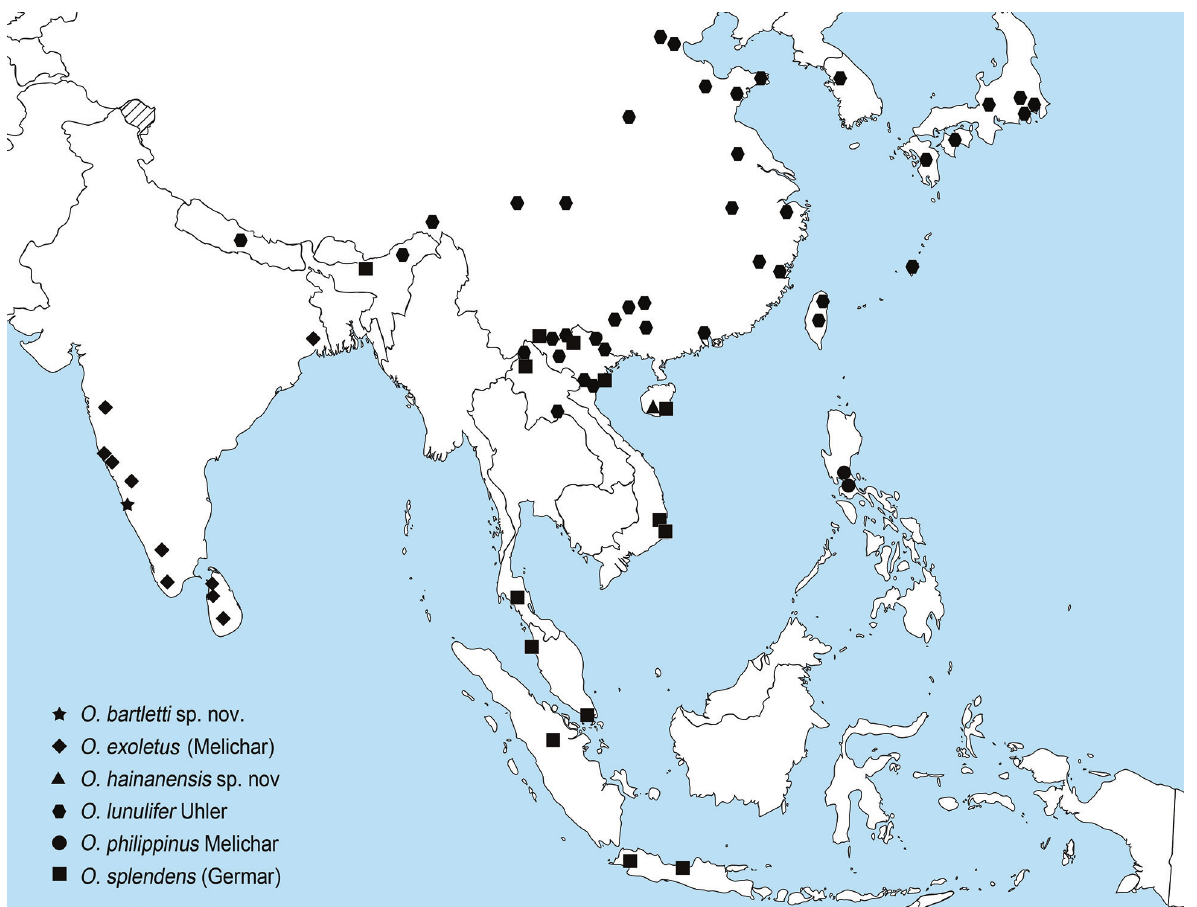
Figure 11. Geographical distribution of the Orthopagus